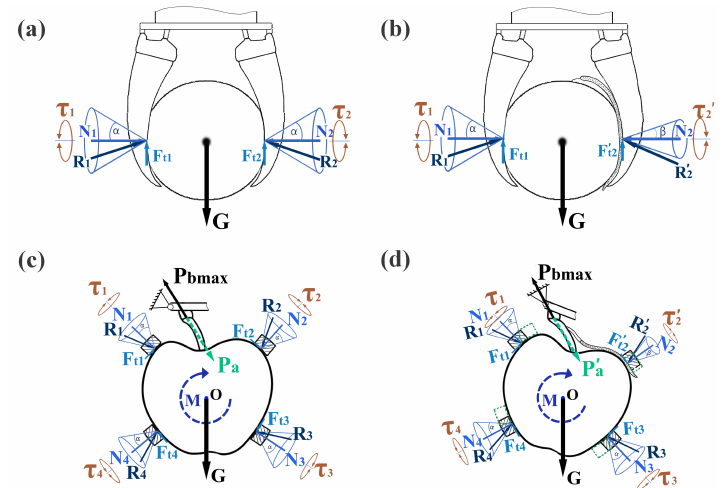
Figure 1. Contact and force analysis of typical grasp scenarios. ( a ) vertical grasp, ( b ) vertical grasp with thin obstacle, ( c ) horizontal grasp, and ( d ) horizontal grasp with leaf interference. Normal forces, equivalent pulling force, and other forces were represented in blue, green, and black color,